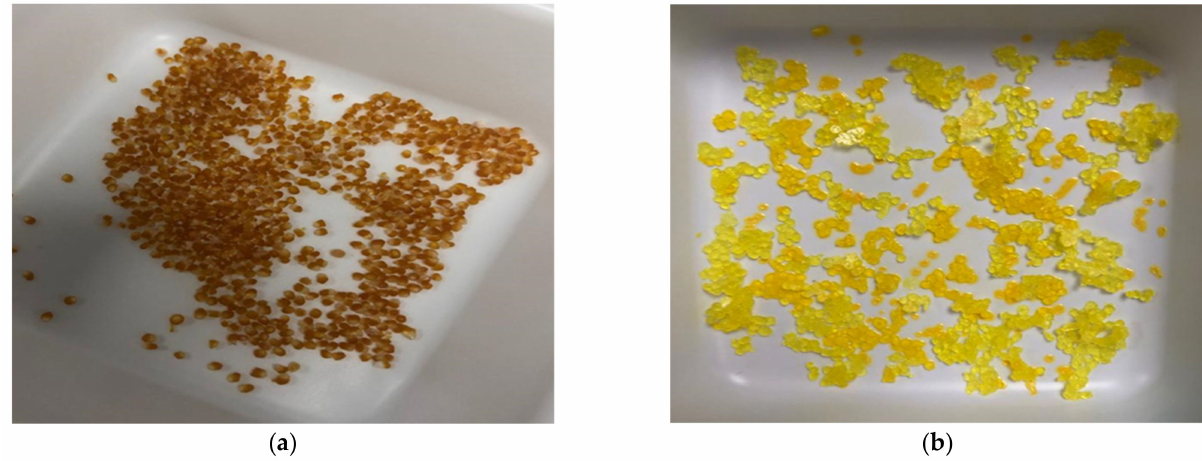
Figure 1. Dried and solidified CUR-MCT-KC and CUR-MCT-KC_2 beads with ( a ) 0.5% w / v CUR-MCT, ( b ) 0.1% w / v CUR-MCT before encapsulated with KC solution. Beads with higher amount of MCT were more yellowish due to a more even CUR